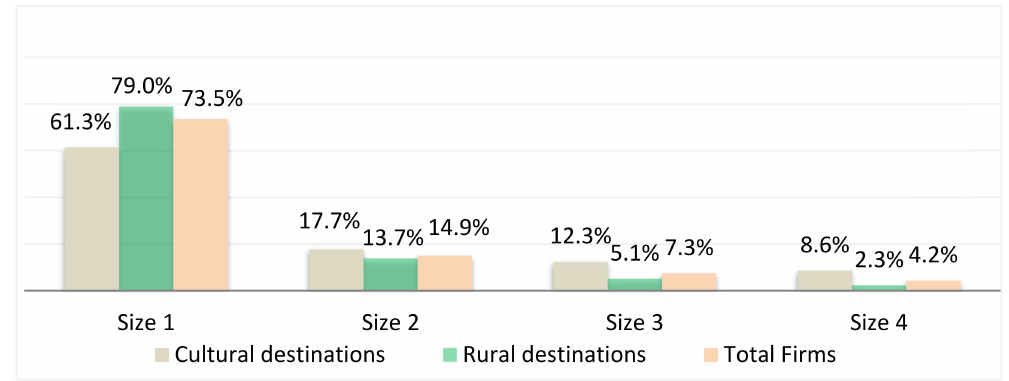
Figure 3. Cultural tourism and rural tourism by size.